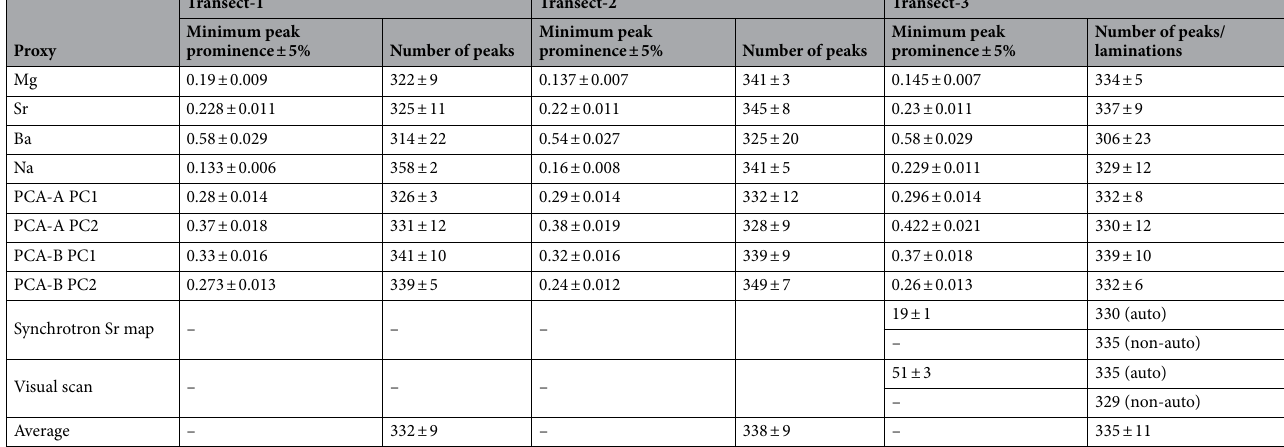
Table 1. The results of counting on a group of trace elements, principal components, and synchrotron and petrography